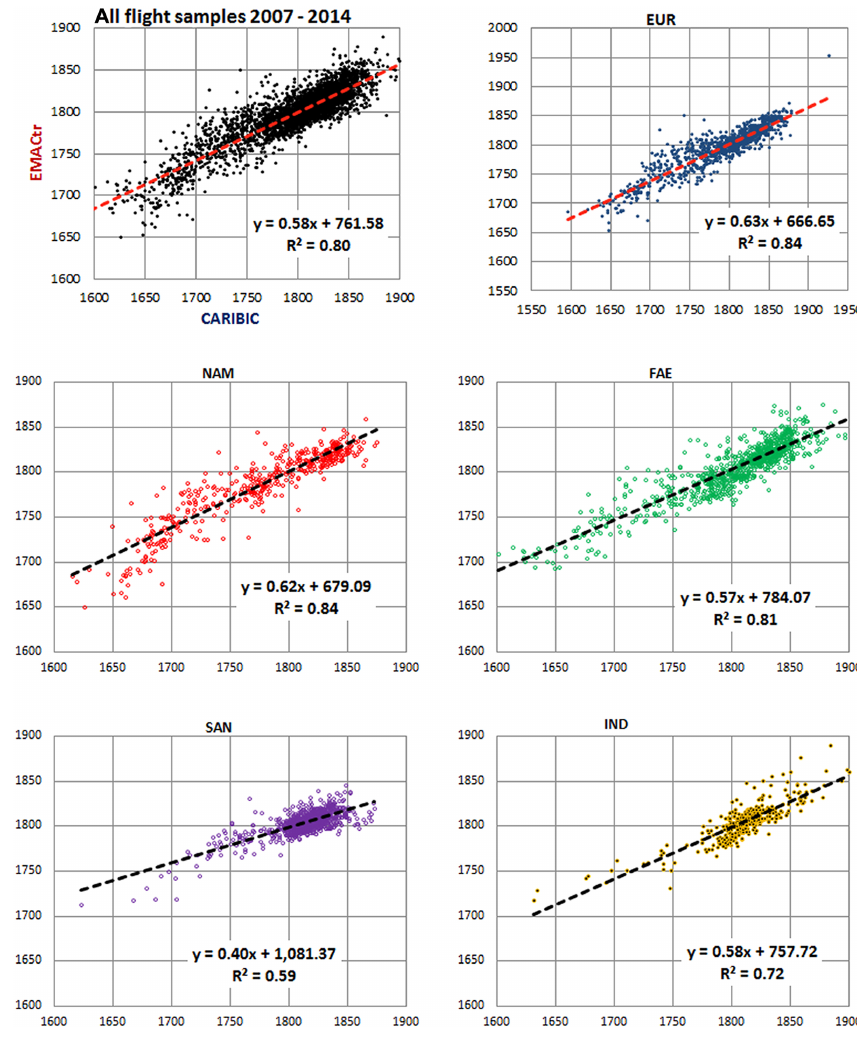
Figure 14. Linear regression between CARIBIC-2 samples and EMAC calculations for all trend period flights (2007–2014) and for flight regions with more than 300